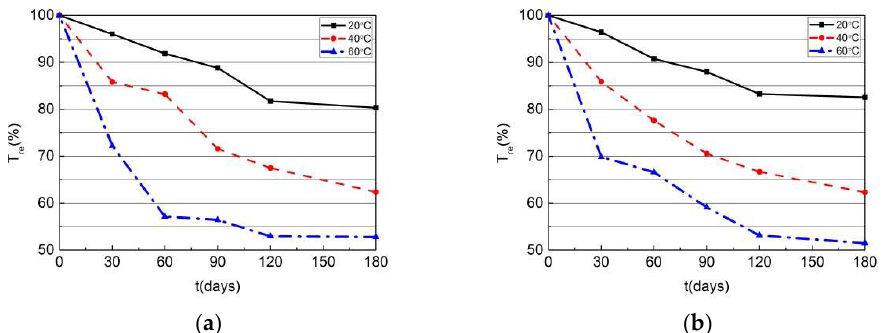
Figure 7. Tensile strength retention of GFRP bars after accelerated aging at different temperatures: ( a ) G1; ( b ) G2.